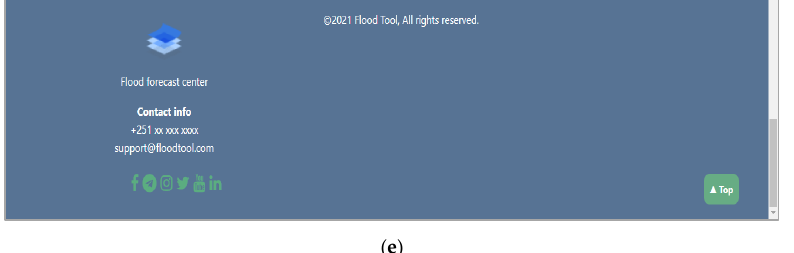
Figure 5. Web interface for Awash and Omo-Gibe flood monitoring system. The flood tool consists of ( a ) Home page (interactive and responsive), ( b ) Forecast products page (precipitation, runoff, and flood maps), ( c ) Visualization page (subbasins, river stations, and plot area), ( d ) Information page (contact us, decision-makers and forecasters), and ( e ) Footnote page (contact info, social links, and Top navigator).